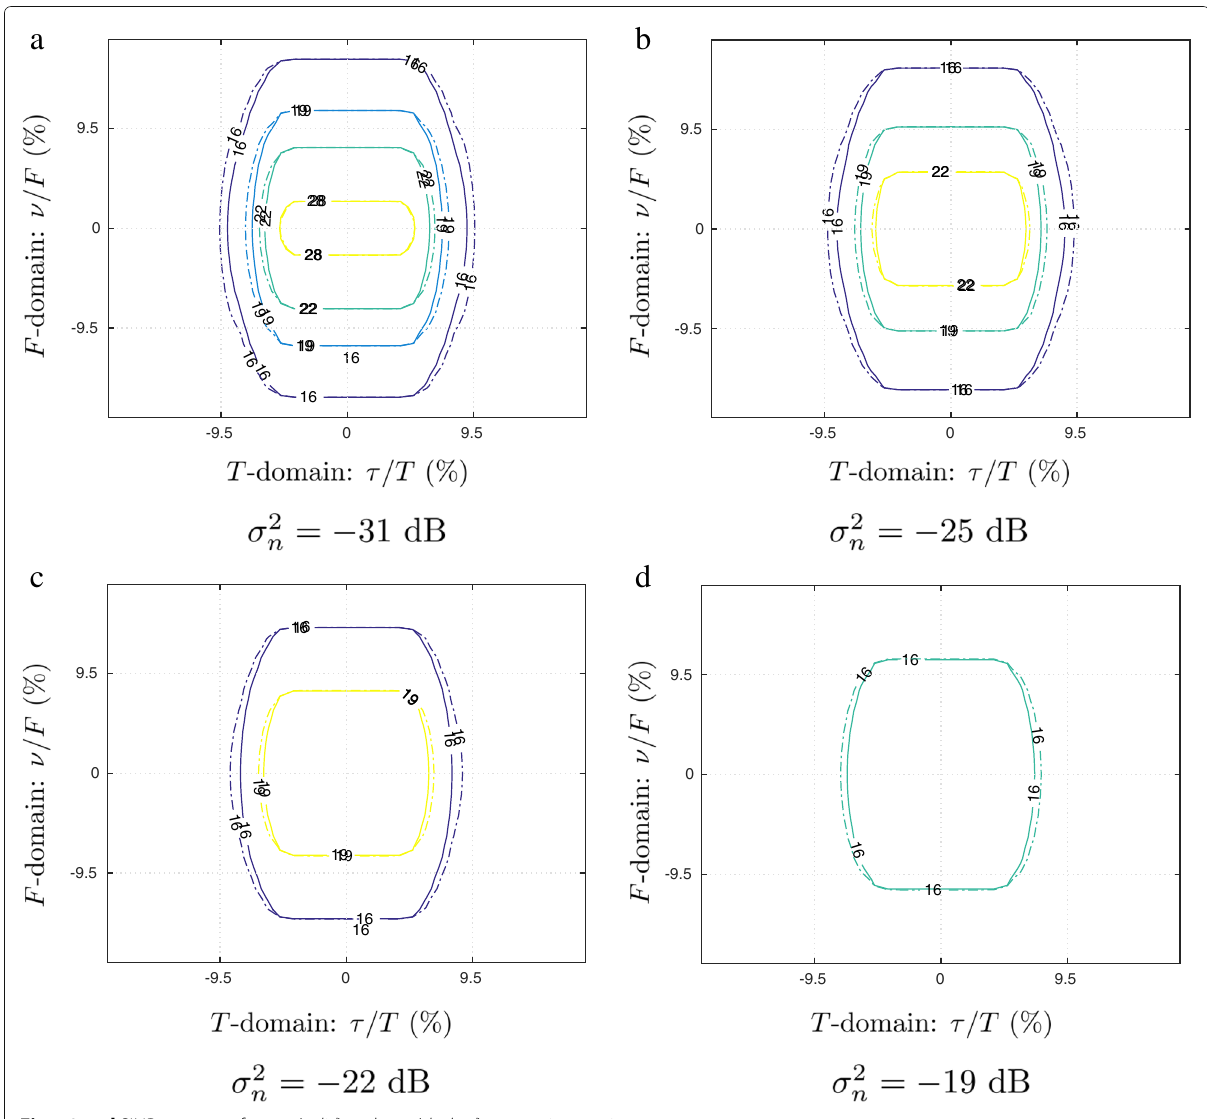
Fig. 10 a – d SINR contour of g RECT ( solid ) and g RC ( dashed ) w.r.t. naive receive γ RECT